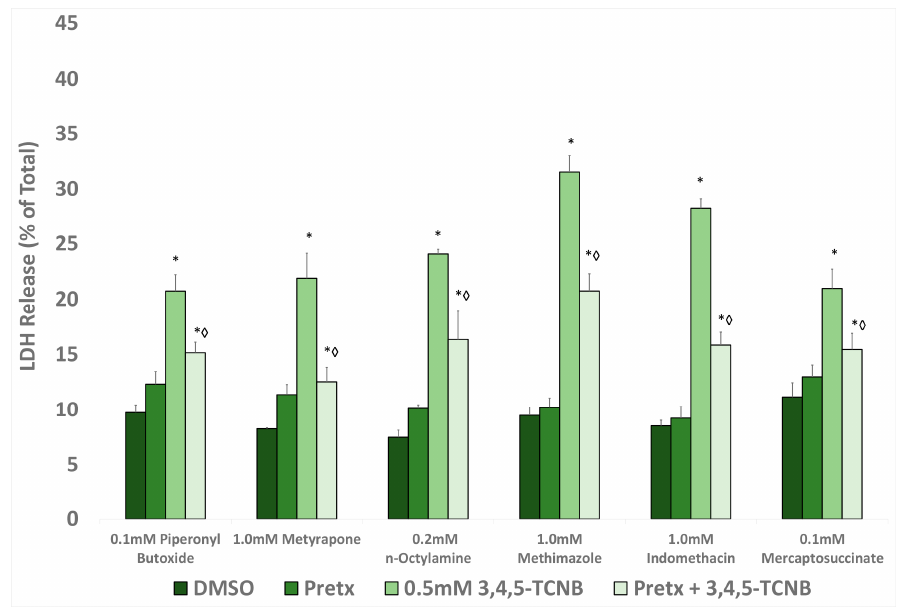
Figure 4. Effects of pretreatment with a cytochrome P450 (CYP) inhibitor (piperonyl butoxide, metyrapone), flavin monooxygenase (FMO) inhibitor (n-octylamine, methimiazole), or peroxidase inhibitor (indomethacin, mercaptosuccinate) on 3,4,5-TCNB 0.5 mM cytotoxicity after a 30 min 3,4,5-TCNB incubation period. An * indicates significant difference from the DMSO control value, p < 0.05. A diamond indicates significant difference from the 3,4,5-TCNB group only value, p < 0.05. n = 4.